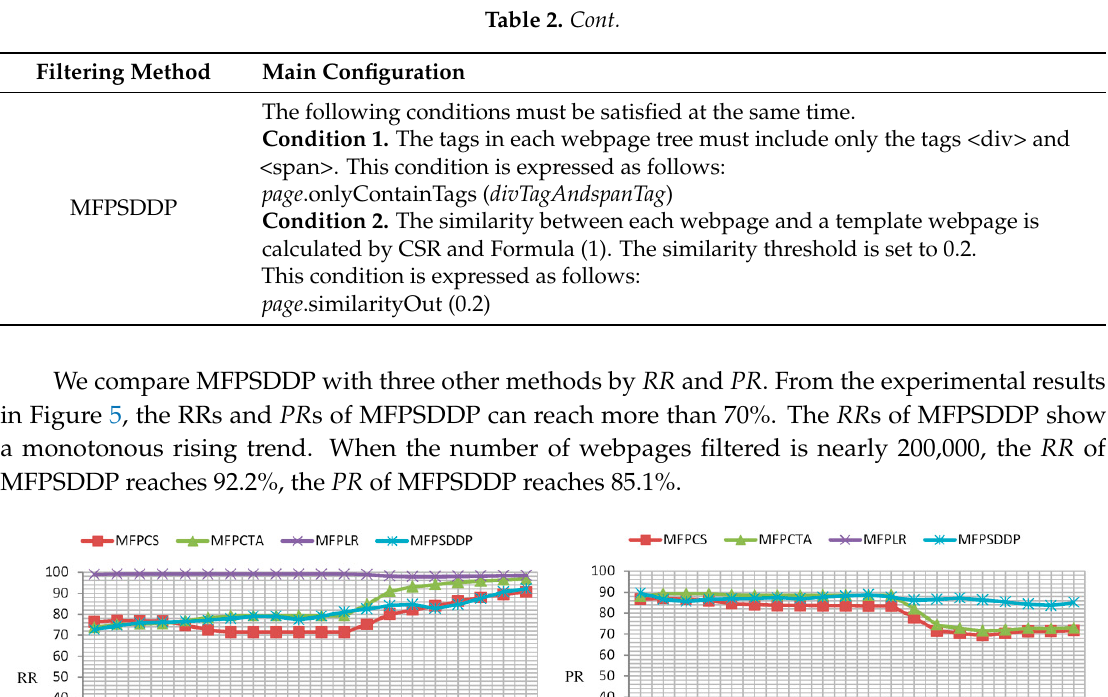
Table 3. The RRs and PRs of four methods when the number of webpages filtered is nearly 200,000.